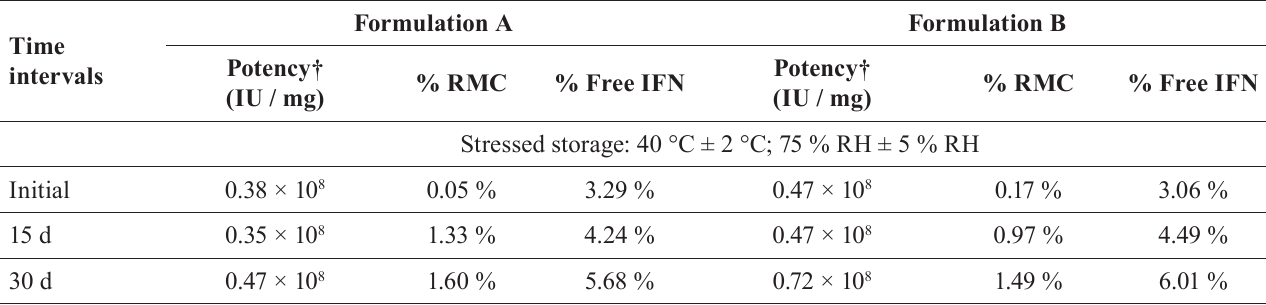
TABLE III - Peginterferon alfa-2b in two different buffer systems: exposed to different temperature